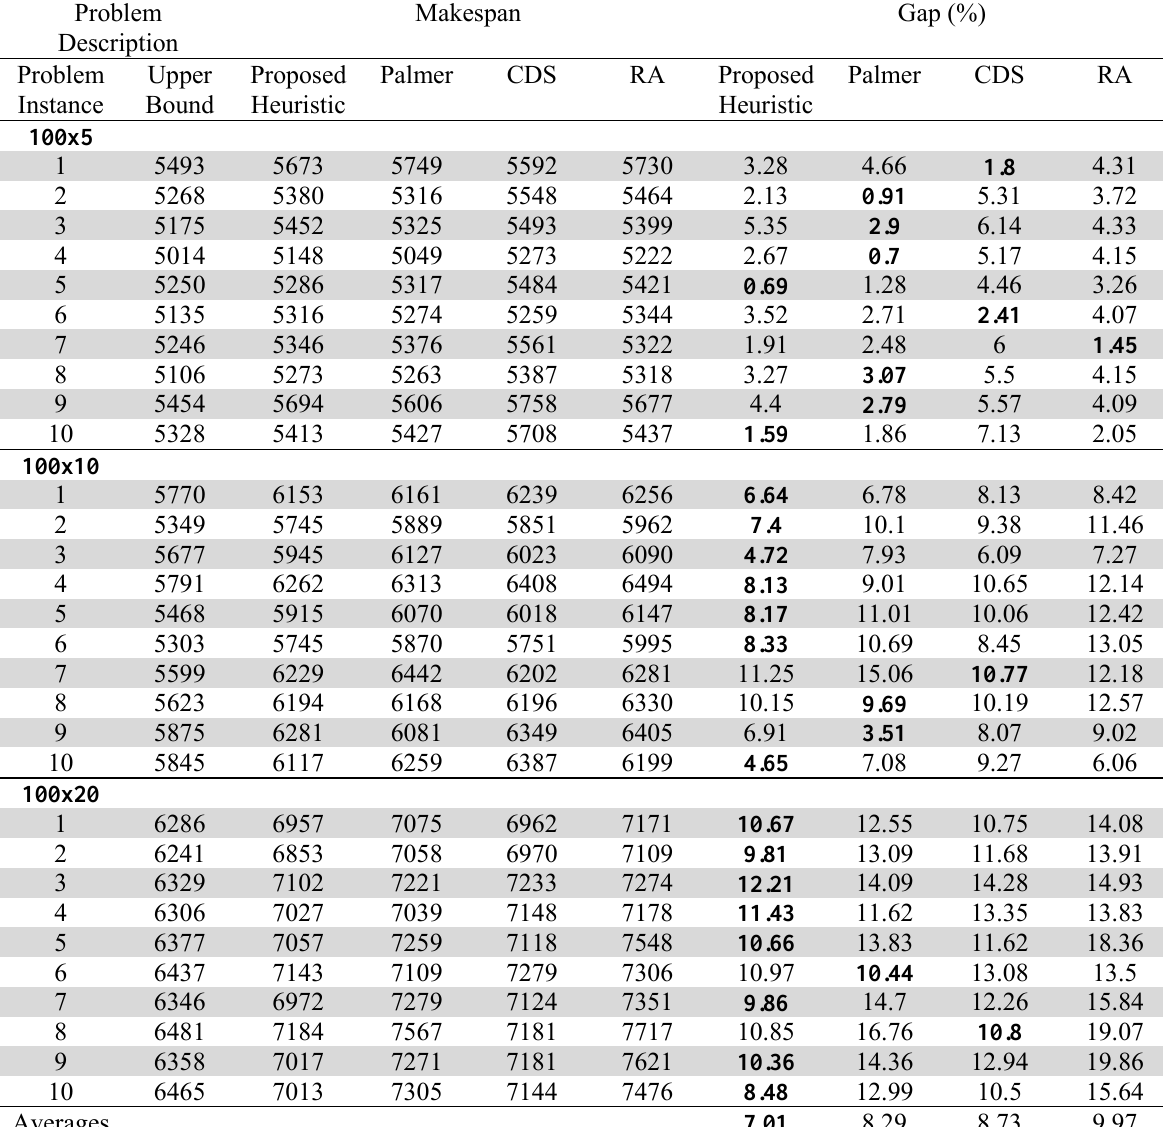
Makespans and percentage gaps for Taillard’s 100-Job benchmark